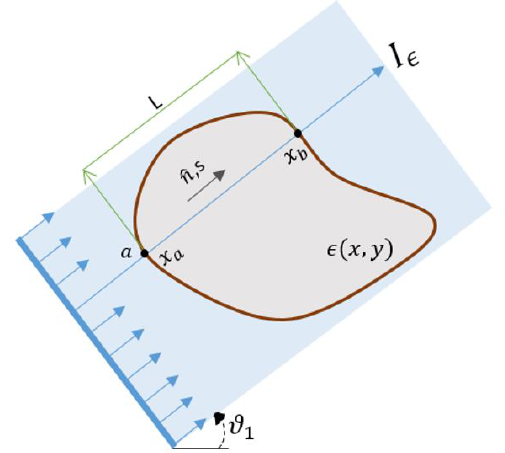
Figure 1. Two-dimensional representation of Longitudinal Ray Transform: showing a ray entering the sample of the thickness L at the position a in the direction of ˆ n